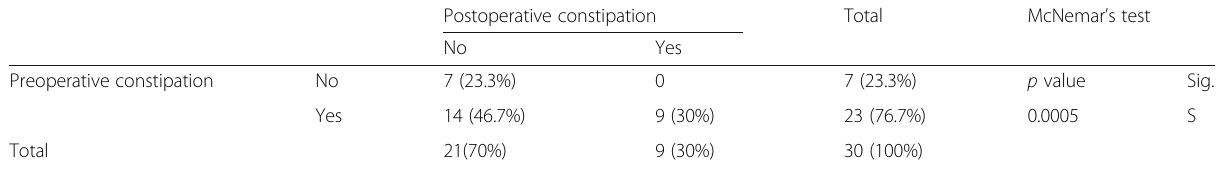
Table 2 Comparison between rate of constipation preoperatively and postoperatively in patients with recto-perineal fistula using McNemar ’ s